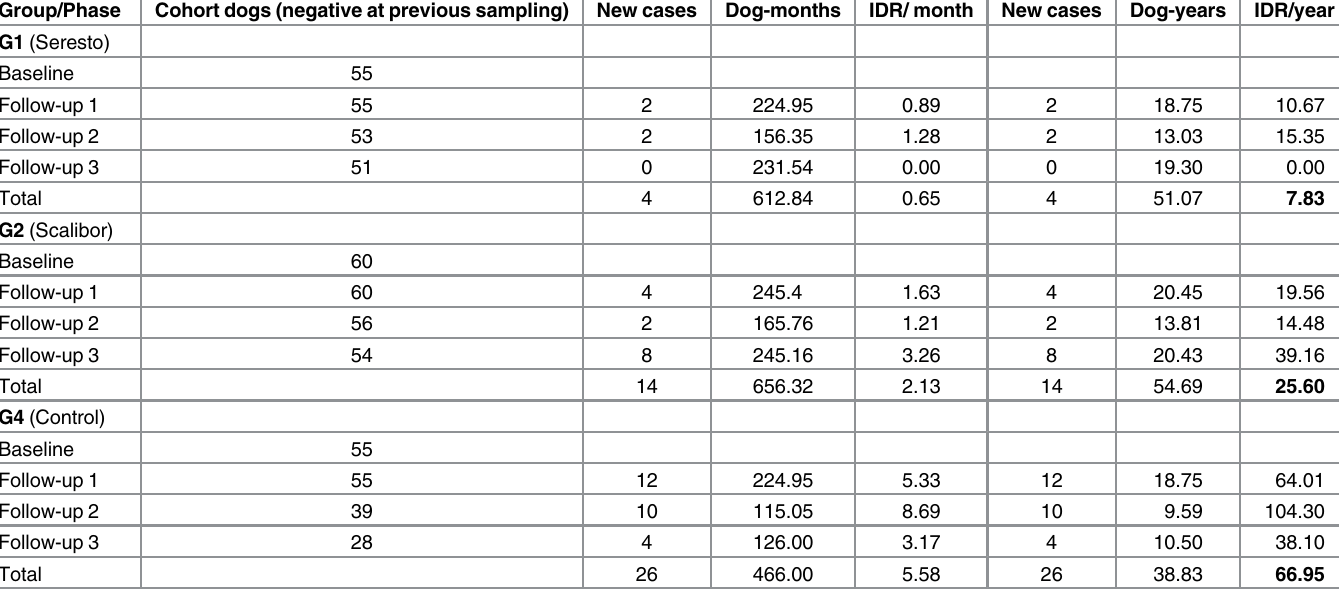
Table 3. Incidence Density Rate (IDR) in the study